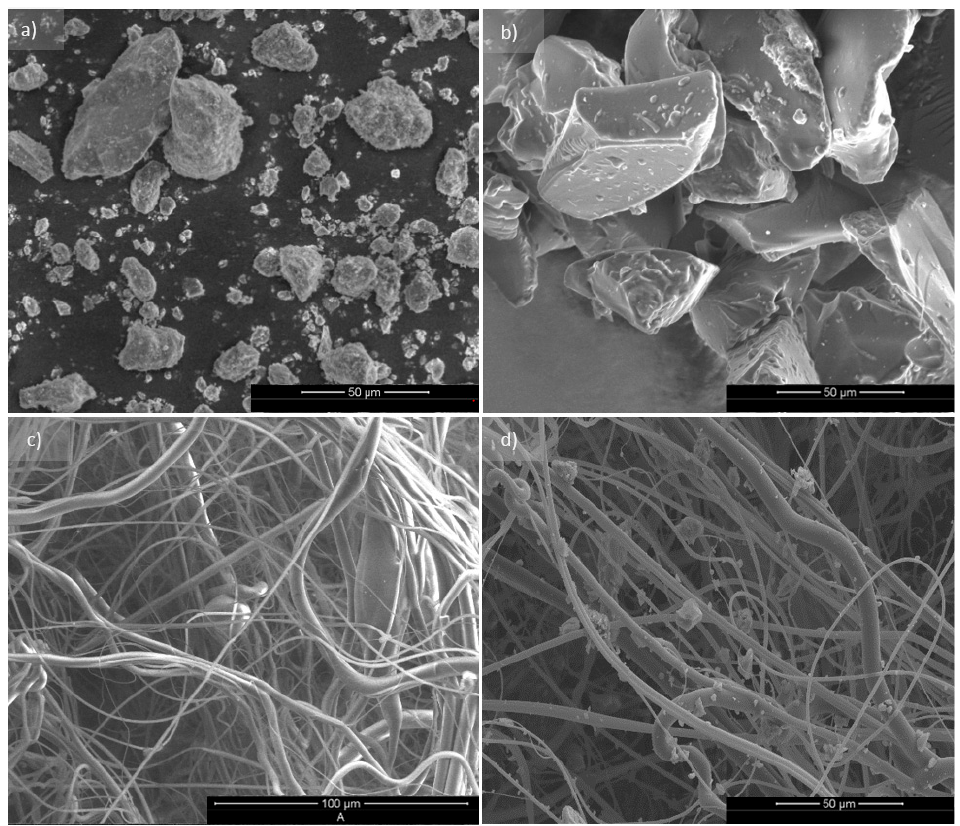
Figure 3. SEM images of Biohaloysite. ( a ) Polymeric superabsorbent (SAP), ( b ) unmodificated nonwoven WSB 0 , ( c ) nonwoven with functional additives WSB 1 , and ( d ) at a magnification of 1600 × .